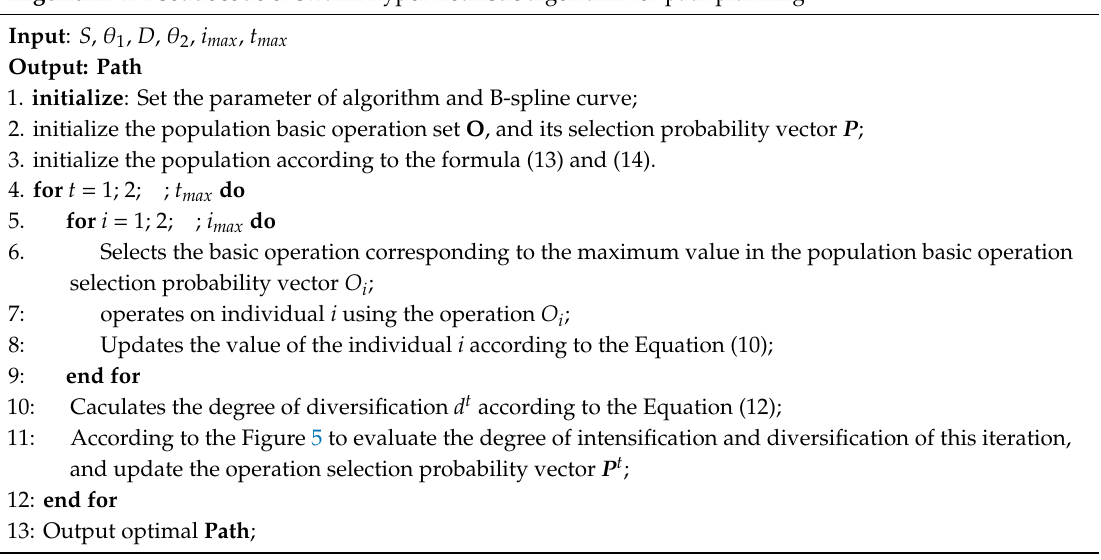
Algorithm 1 : Pseudocode of swarm hyper-heuristic algorithm for path